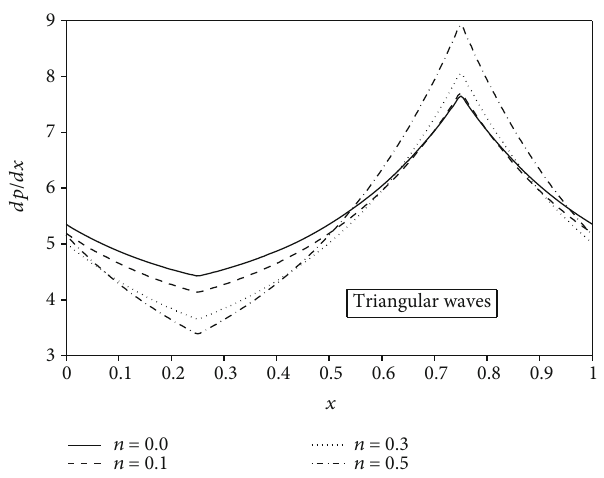
Figure 11: Variation of pressure gradient with x for di ff erent values of n for fi xed values of φ = 0 : 5 , β = 6 , We = 0 : 6 , and Q = − 3 : 5 .